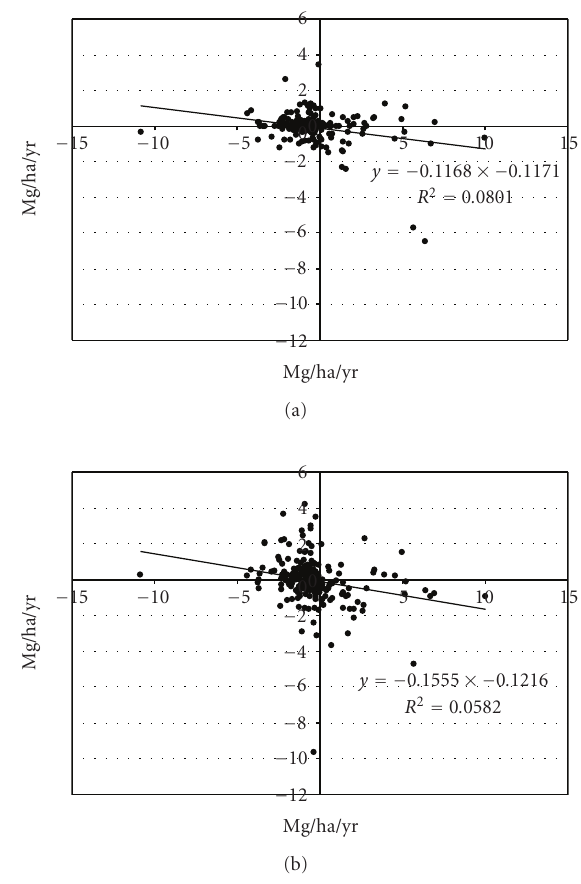
Figure 6: Scatter plots of (a) standing dead and (b) down dead woody material C stocks by standing live tree C stocks across the north central United States, 2002 to 2007.